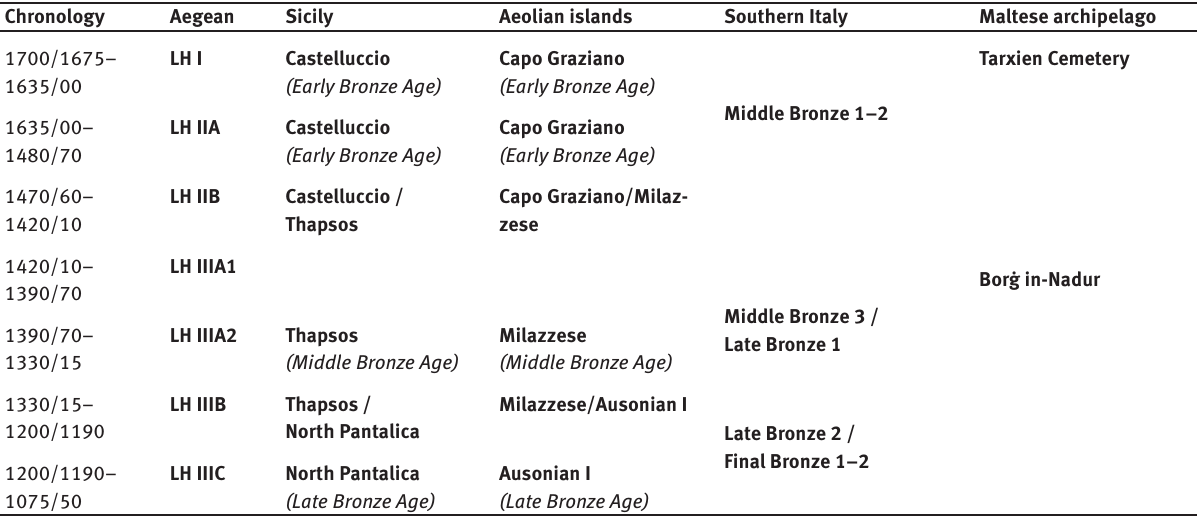
Table 1: Comparative chronological chart for Aegean, Sicilian, Southern Italian and Maltese Bronze Age with indication of the main cultural facies (Aegean chronology after Manning,